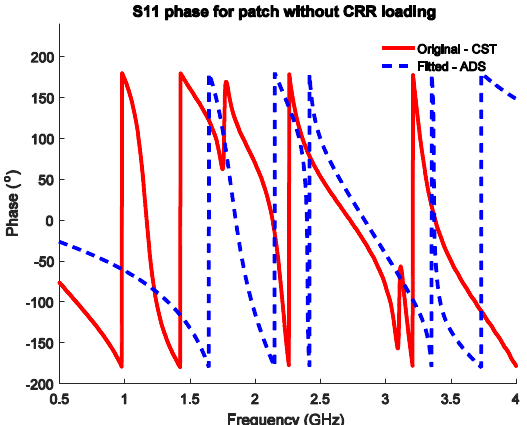
Figure 12: S11 original and fitted magnitude for patch without CRR.